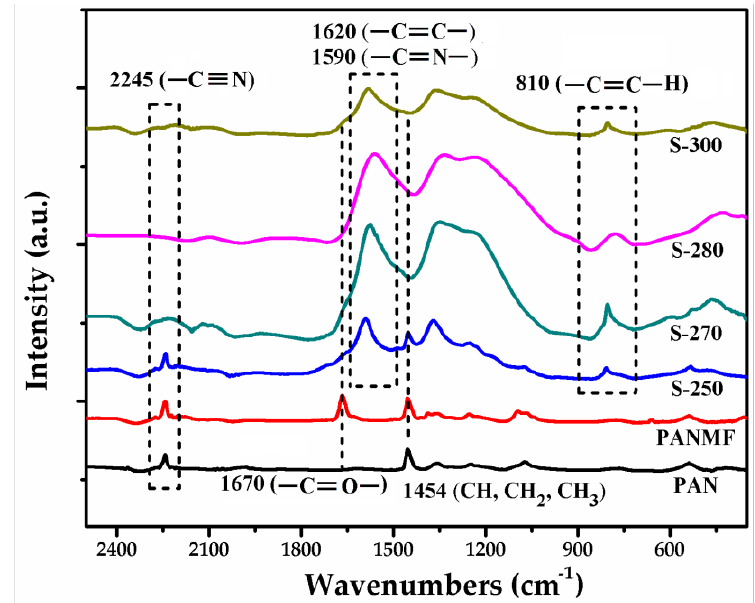
Figure 1. FTIR spectra of PAN, PANMF, and PANMFs stabilized at 250, 270, 280, and 300 °C.